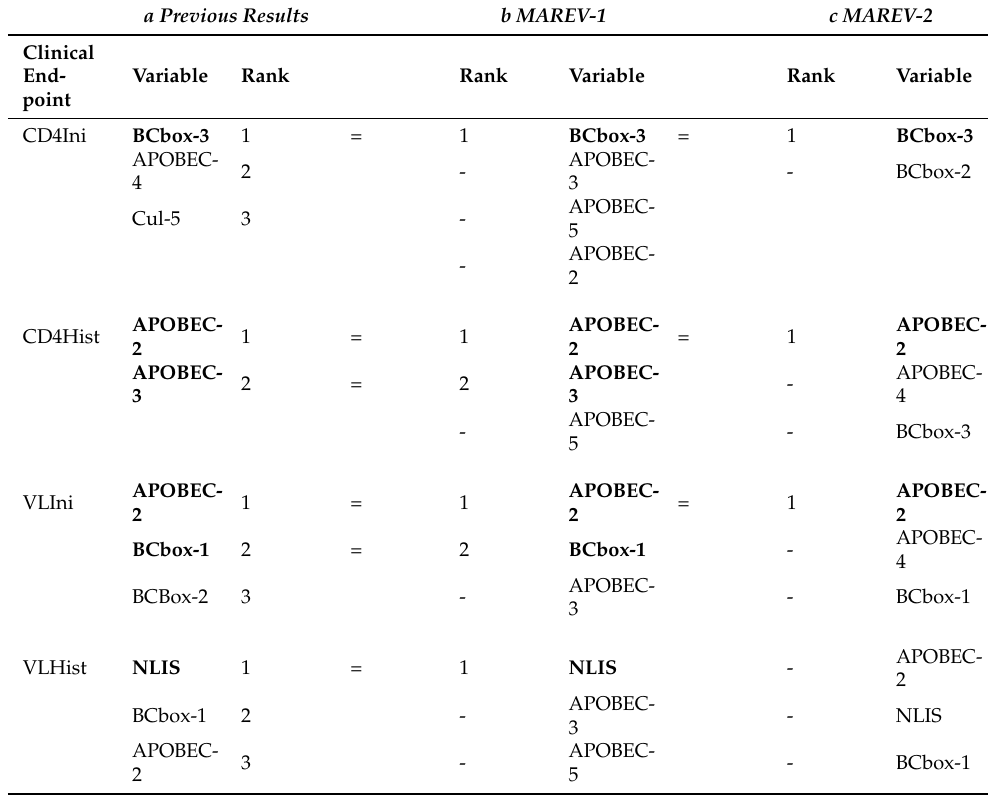
Table A7 compares the findings of MAREV-1 and MAREV-2 with the previous results. Table A7. Variables with the highest scores per clinical endpoint. a, Previous results [20]; b, Consider- ing the MAREV-1 approach; c, Considering the MAREV-2